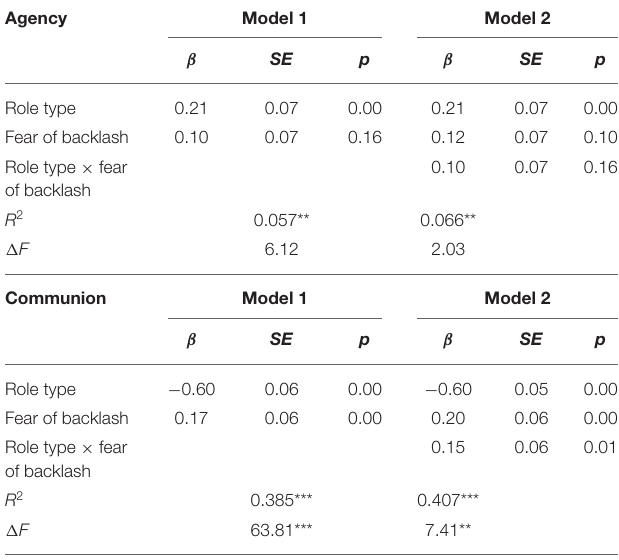
FIGURE 2 | Self-reported agency and communion at work for female senior executives and female lecturers in Study 2 under imagination research paradigm. Error bars represent the SE of the mean. *** p < 0.001, ** p < 0.01. N = 207 women ( N Executive = 104, N Lecturer = 103). TABLE 3 | Hierarchical regression analyses for the moderator effect of fear of backlash on the relationship between role type of women and self-reported agency and communion in Study